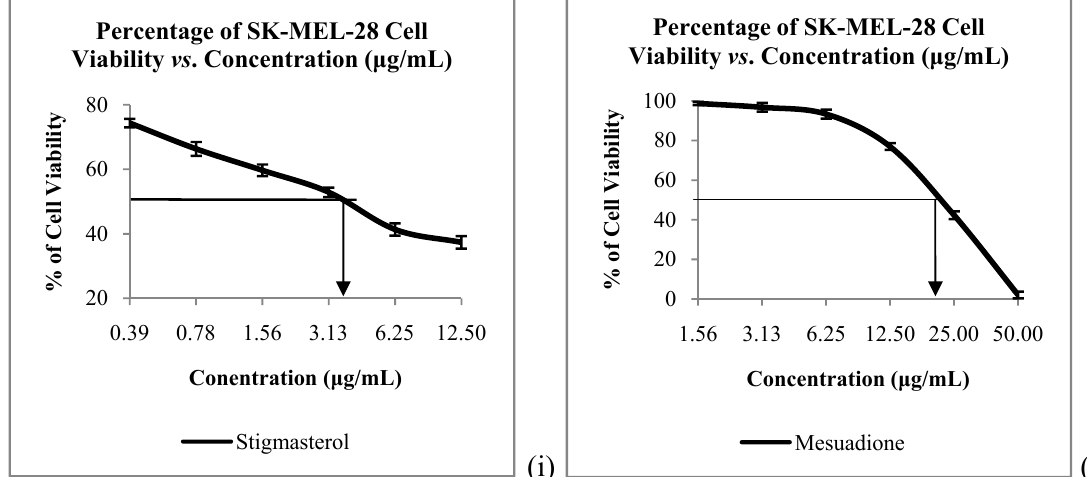
Figure 4. Cytotoxicity of Compounds 1 – 6 towards (i), (ii) SK-MEL-28, (iii) IMR-32; (iv) HeLa; (v) HEP G2 and (vi) NCI-H23 Cells. Bars denote statically significant differences at p < 0.05. Each data point represents the mean ± SD of three independent